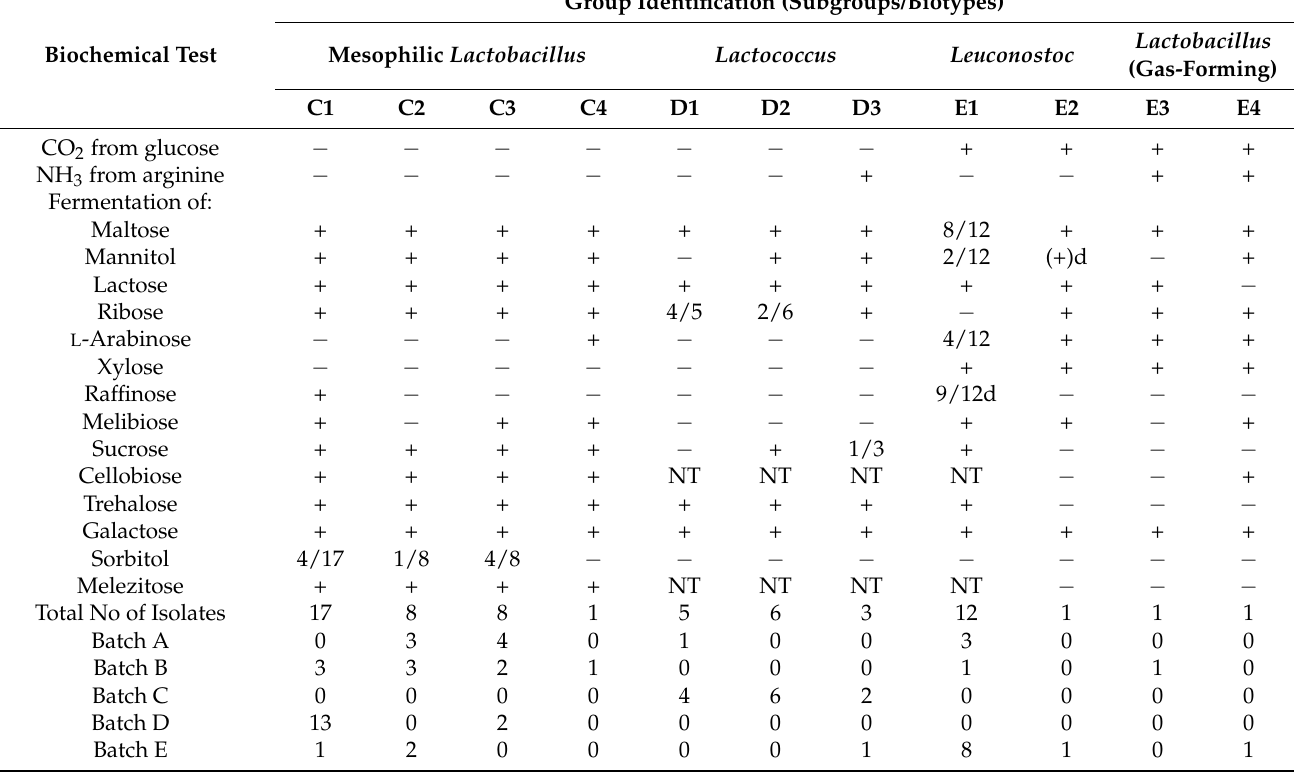
Table 5. Biochemical characterization of 66 mesophilic LAB isolates from five retail RTE Galotyri-like acid-curd cheese batches and their numerical distribution in each cheese